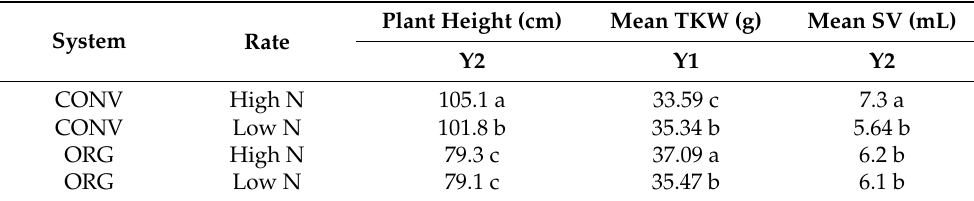
Table 2. Plant height (cm), 1000 kernel weight (TKW, g) and sedimentation value (SV, mL) as affected by system and fertilizer N rate. (Same letters within each column are not significantly different based on Tukey’s honest significant difference (HSD) test performed at α = 0.05).